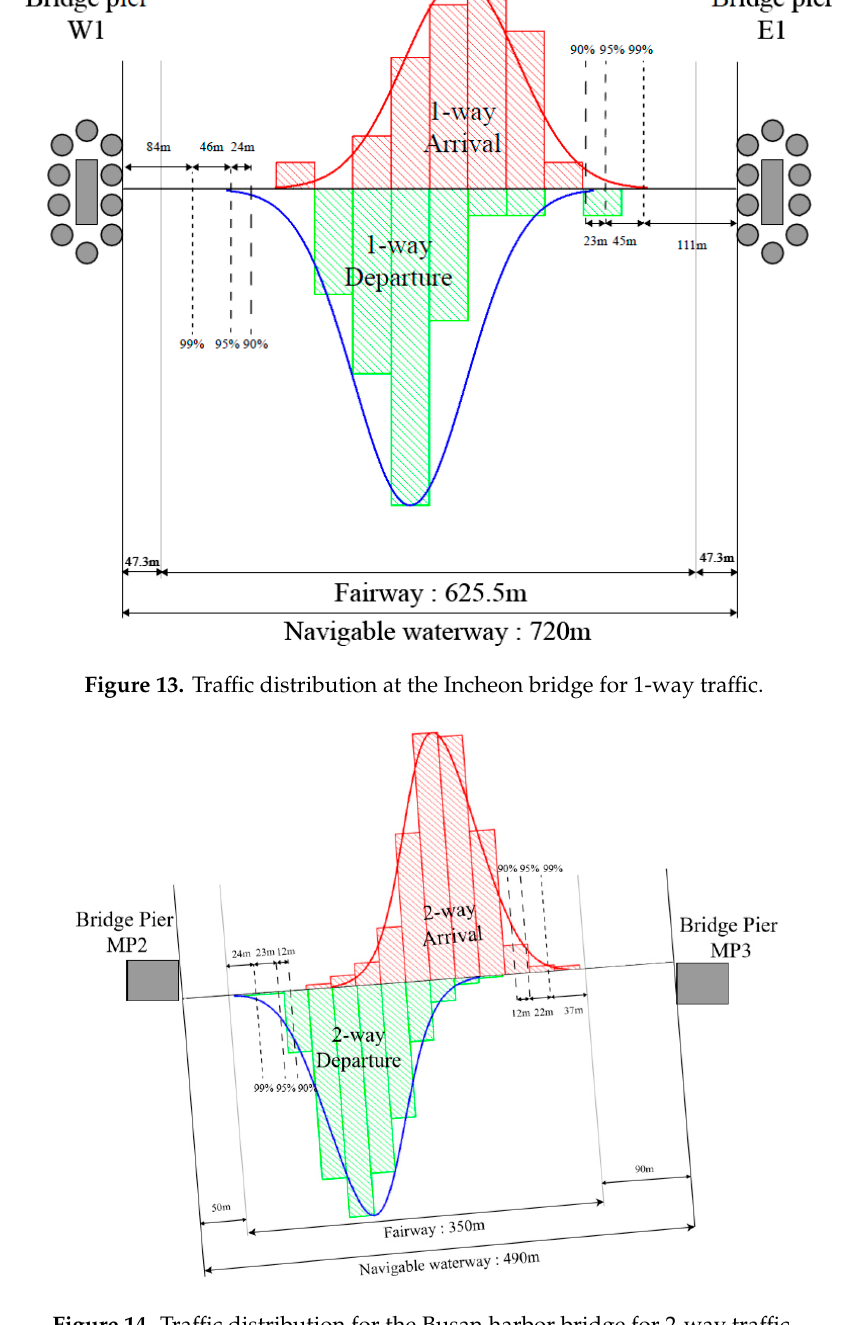
Table 12. Maximum breadth of bridge crossing waterway.